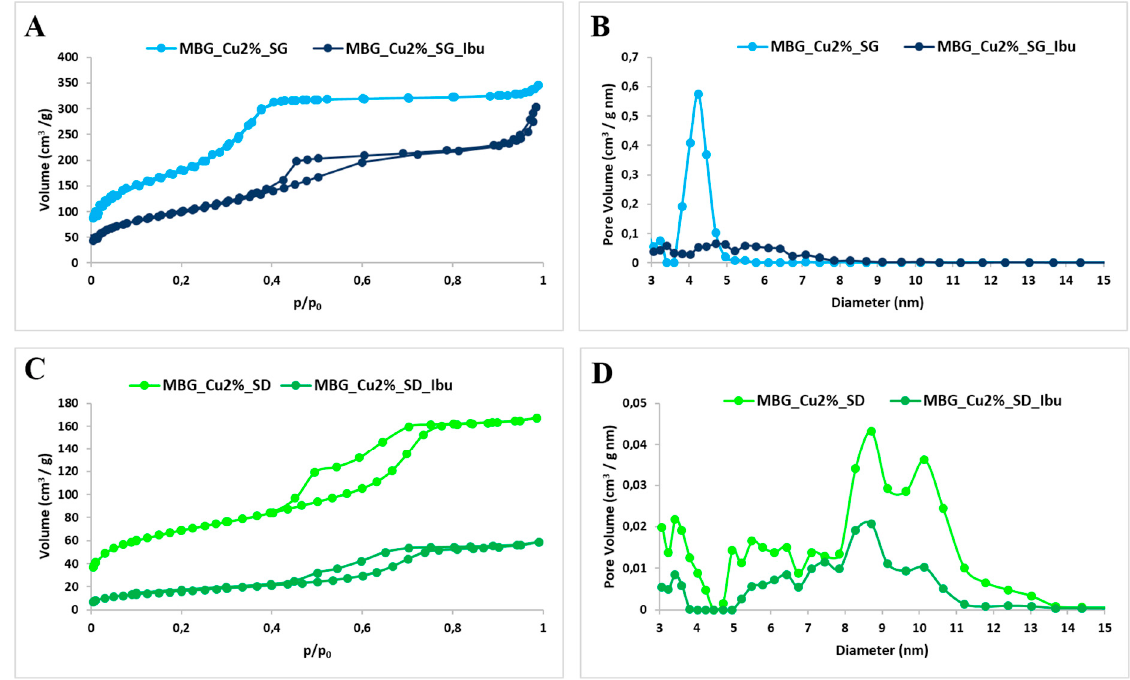
Figure 2. N 2 adsorption–desorption isotherm of MBG_Cu2%_SG and MBG_Cu2%_SG_Ibu ( A ),